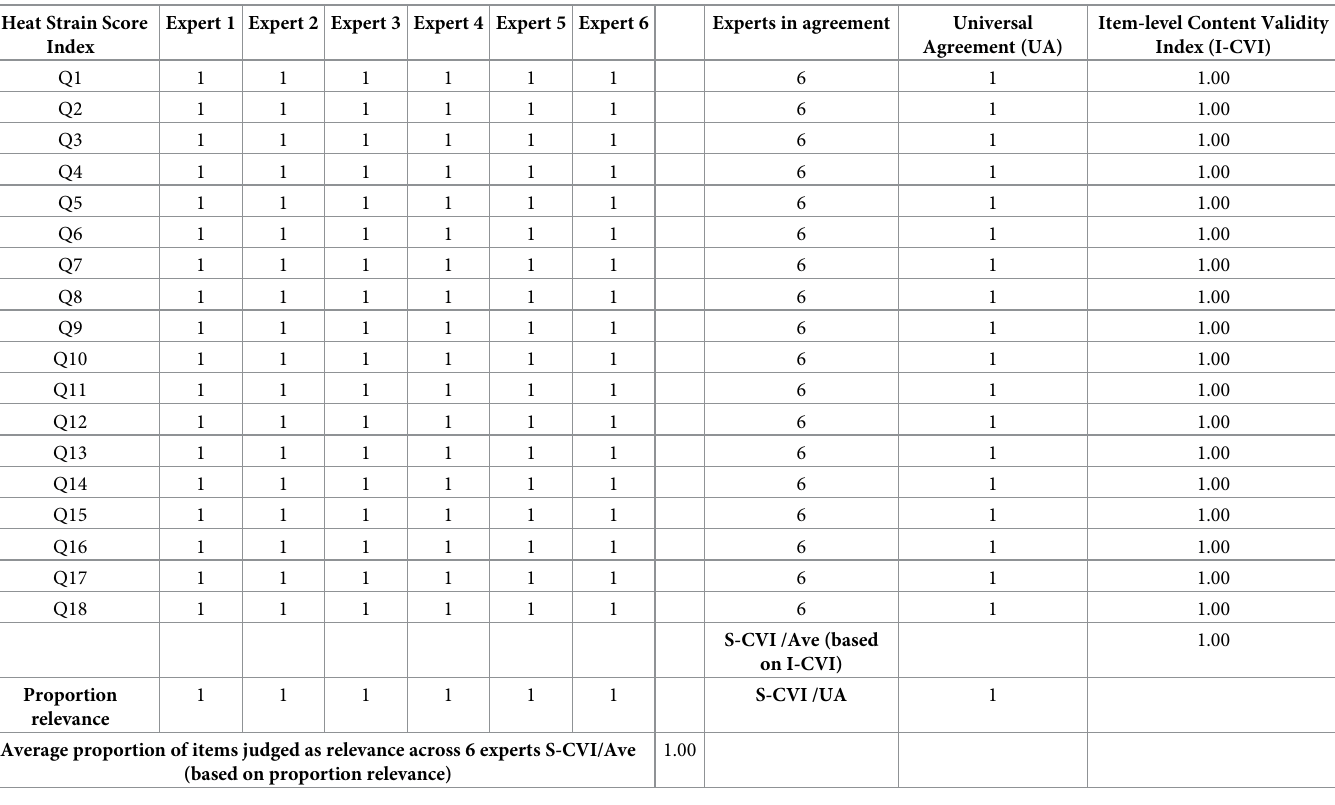
Table 2. The relevance ratings on the item scale by the six experts and the calculation of different CVI indices for the translated Malay version of